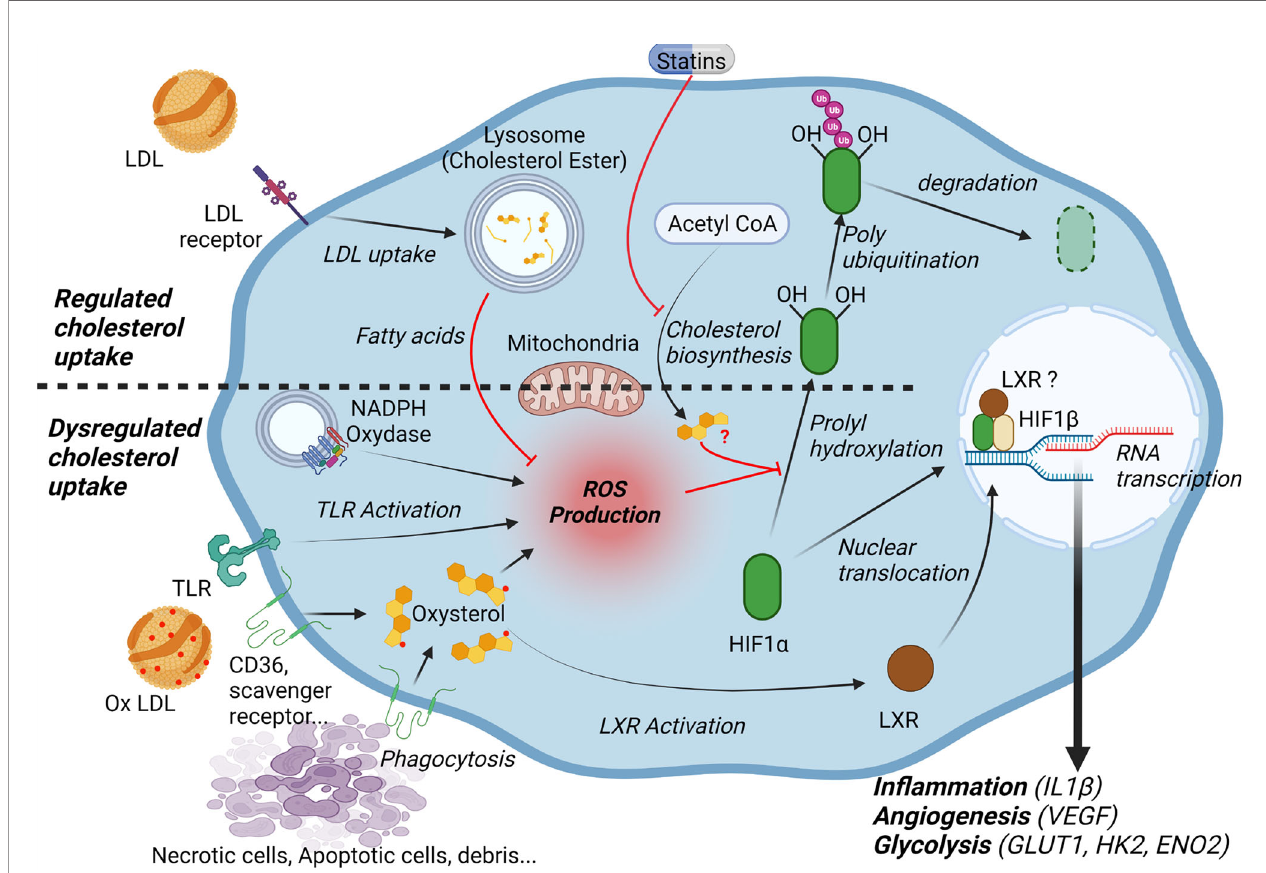
FIGURE 1 | Cholesterol and lipid microenvironment regulate HIF-1 a . Low density lipoproteins (LDL) are taken up into the cells via endocytosis of the LDL receptor (LDLR). Fatty acids released by the lysosomal hydrolysis of cholesteryl esters inhibit mitochondrial reactive oxygen species (ROS) production and decrease HIF1 a stability. Cholesterol synthesis may also affect HIF-1 a dependent pathways through the generation of isoprenoids and subsequent isoprenylation of G-proteins. In the context of atheroma, macrophages engulf oxidized lipoproteins and oxysterol-rich cellular debris, which leads to ROS production and increases HIF-1 a stability. Moreover, oxysterol accumulation activates the Liver X Receptor (LXR). LXR may directly interact with HIF-1 a . Overall, HIF-1 a activation promotes the expression of genes implicated in in fl ammation (interleukin 1- b ), angiogenesis (vascular endothelial growth factor (VEGF) and glycolysis (glucose transporter 1 (GLUT1), hexokinase 2 (HK2), enolase 2